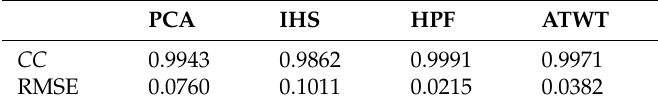
Table 4. The correlation coefficient (CC) and RMSE between original MNDWI 20m image and